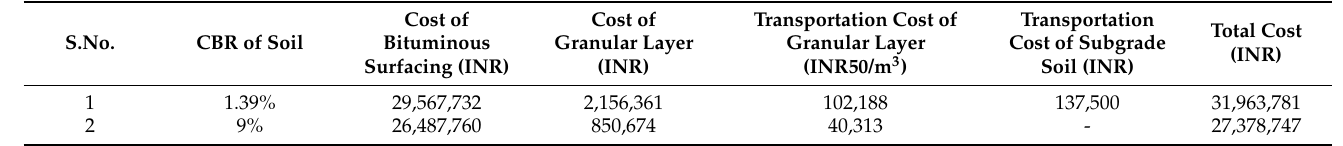
Table 5. Cost analysis of 5% and 9% CBR